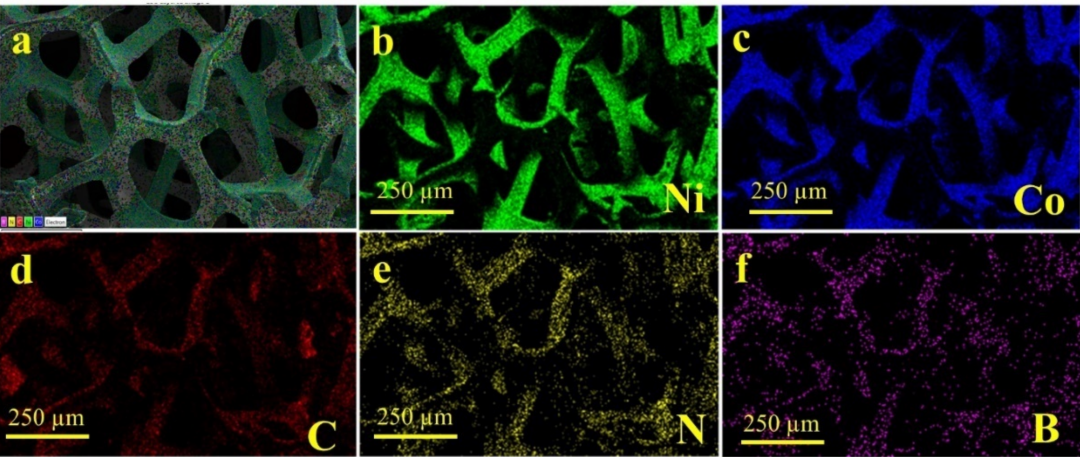
Figure 2. Elemental mapping images of the as-prepared CoB/g-C 3 N 4 @NiF; ( a ) all of the elements are shown together, and the individual ones ( b – f ) for Ni, Co, C, N, and B shown in the various visible